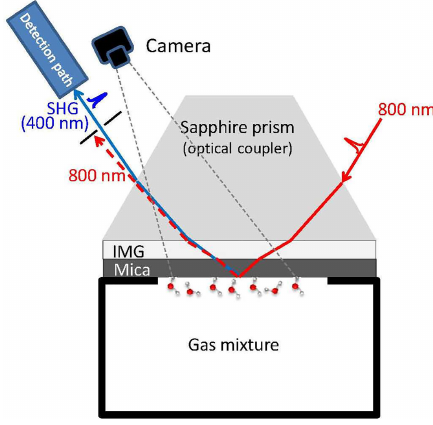
Figure 1. The sample and beams geometry. See text for